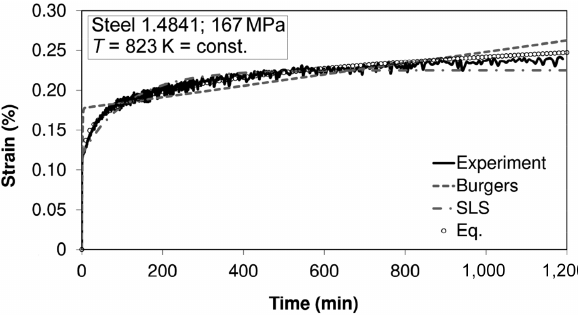
Figure 7: Experimental creep curve and modelled creep curves for steel 1.4841 at a temperature of 823 K.